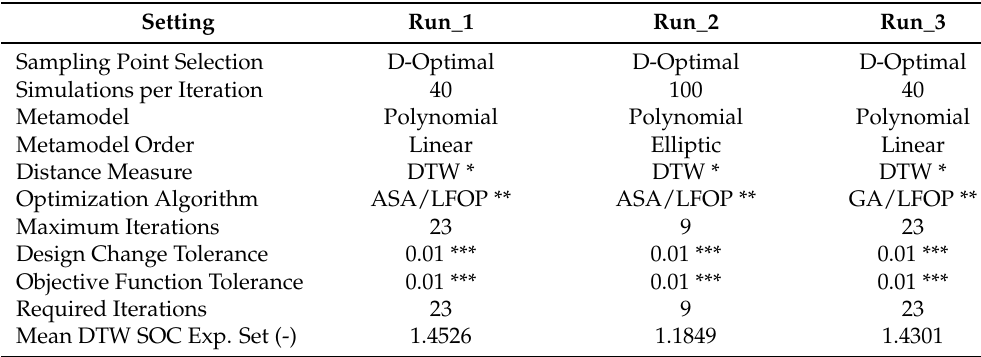
Table A1. LS-OPT settings of 1 Step Strategy for iterative optimization-based calibration and results (*—except for PEC Compression Test; **—when the global optimum is found, switch to LFOP to find best local optimum; ***—default).